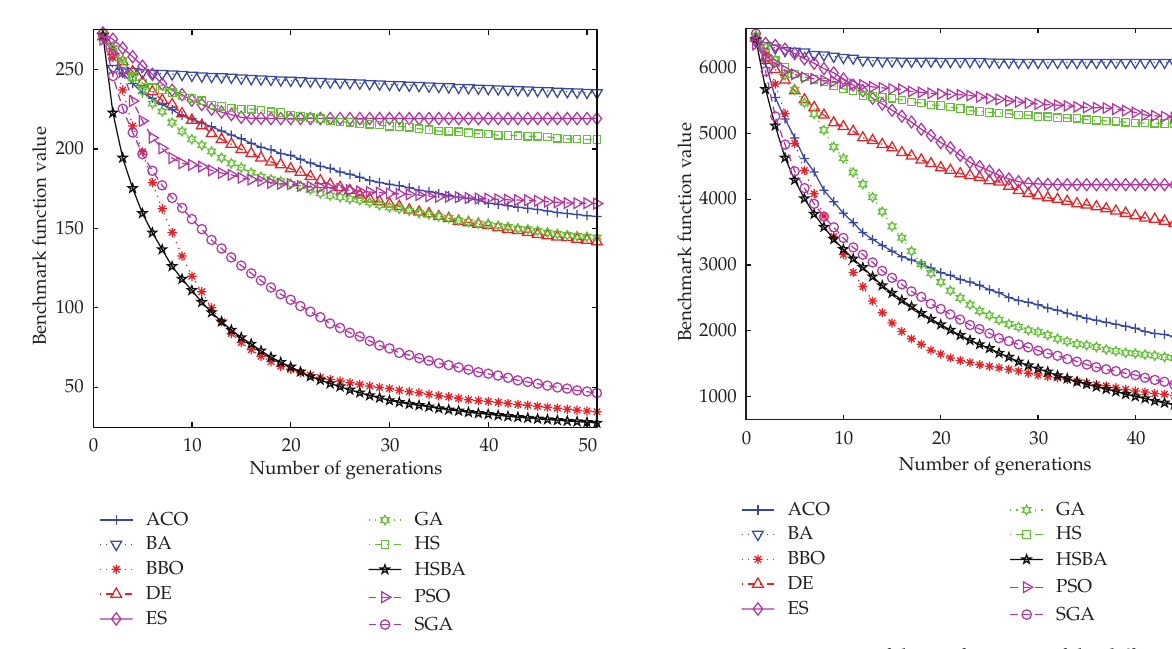
Figure 7: Comparison of the performance of the different methods for the F07 Rastrigin function.